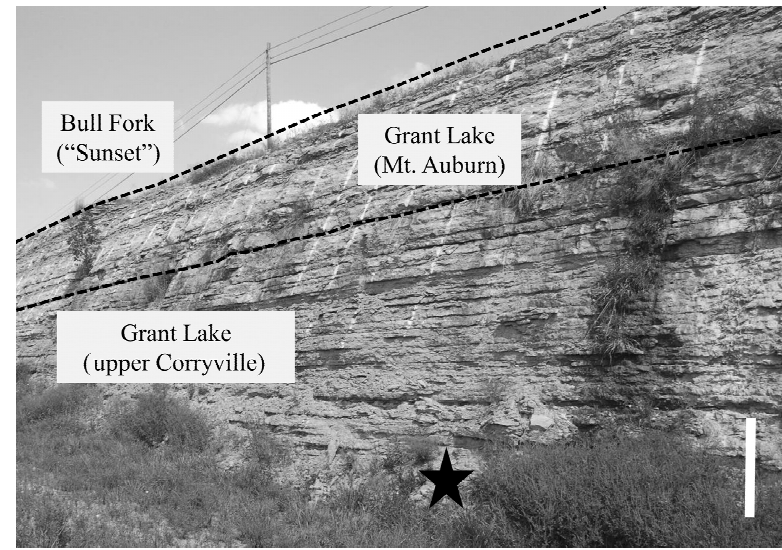
Fig. 2. Outcrop photograph of the study site, showing the upper part of the Grant Lake Formation and the lowermost, largel y eroded, Bull Fork Formation. The star marks the approximate position of the talus pile from which the pluricolumnal was recovered. Scale bar = 1